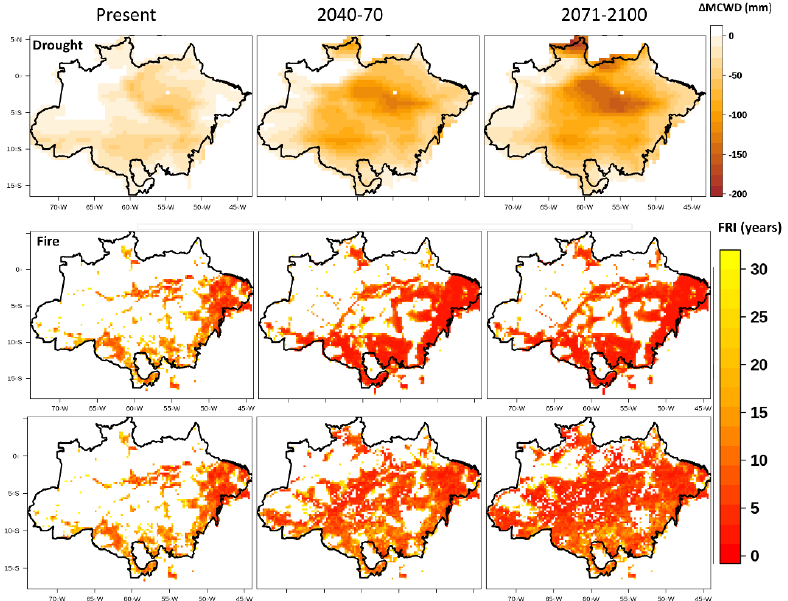
Figure 6. Projected changes in droughts (as maximum climatological water deficit anomalies, ∆ MCWD) ( upper panel ) and fire return interval based on an optimistic land use scenario ( mid panel ) and in the unmitigated scenarios with the worst‐case land‐use scenario ( bottom panel ).